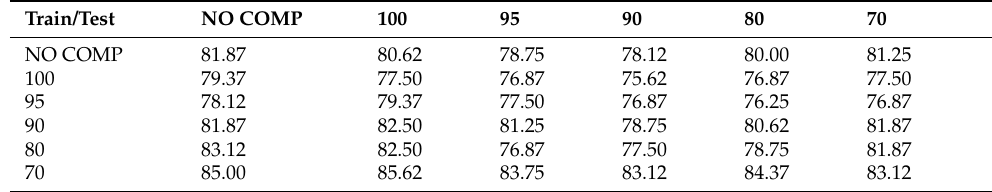
Table 9. Accuracy obtained by FN 512 with different JPEG quality factors (reported in